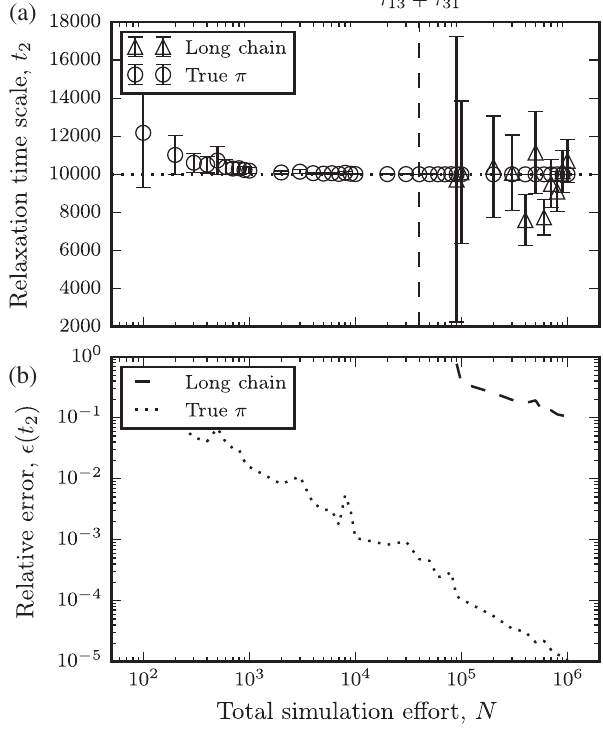
FIG. 1. Mean and standard error of the largest implied time scale t 2 total simulation effort N for metastable three-state system with barrier parameter b ¼ 4 . (a) Convergence of the mean value, using either a single long trajectory starting in one of the metastable states or the equilibrium distribution together with an ensemble of short chains relaxing from the transition state. The latter approach allows us to obtain a reliable estimate before the average waiting time for a single rare event τ 13 þ τ 31 has elapsed. The comparison of the estimated standard error (b) indicates a 3 orders of magnitude speed-up when estimating the rare-event sensitive quantity t 2 using the equilibrium distribution in combi- nation with short relaxation